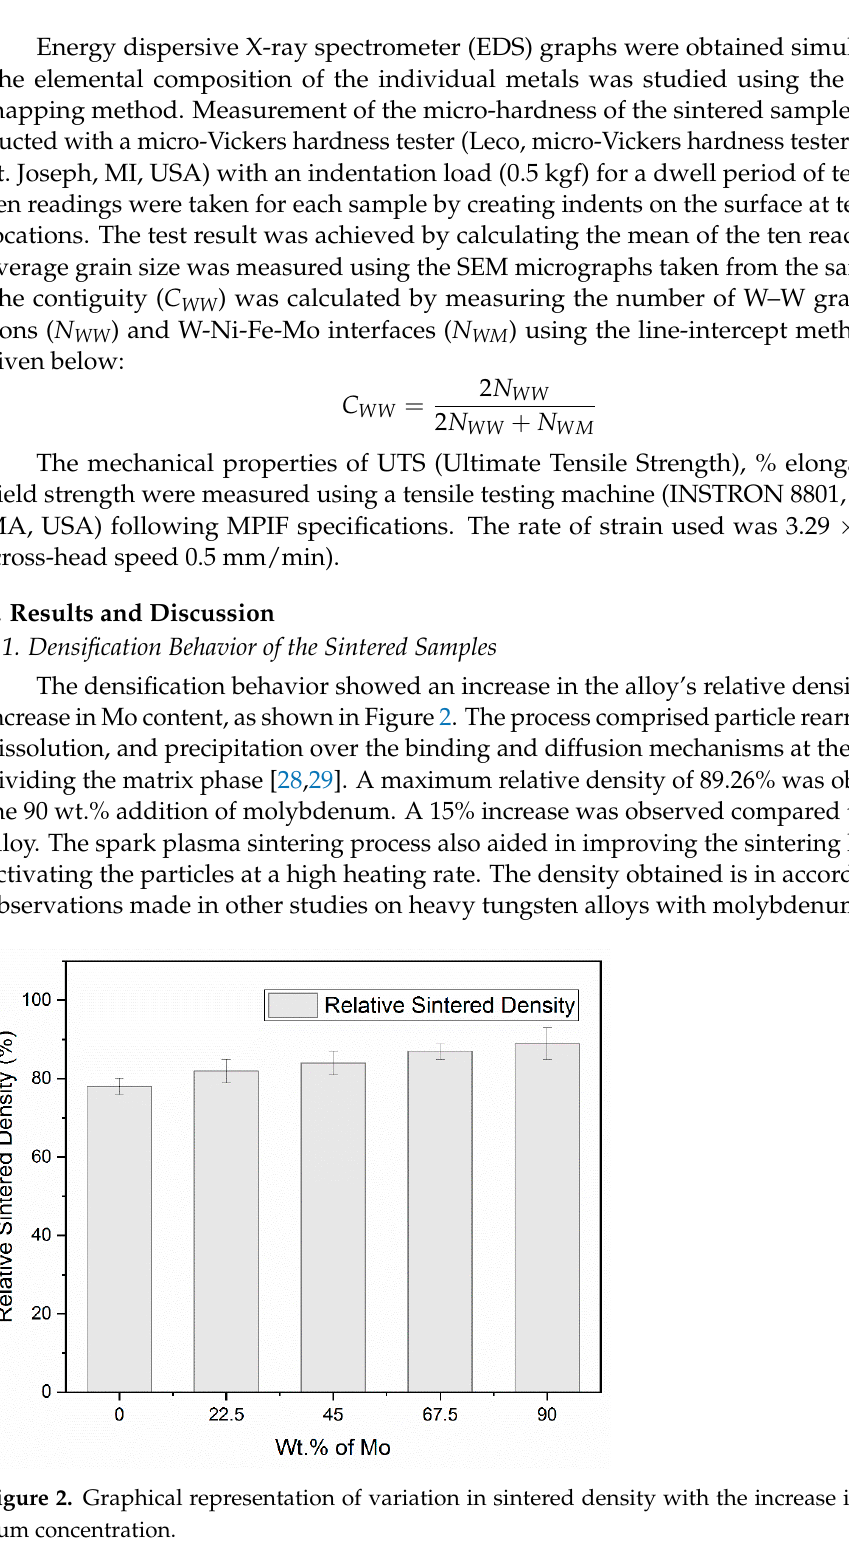
Figure 1. Powder morphology of ( a ) tungsten, ( b ) nickel, ( c ) iron, and ( d ) molybdenum.